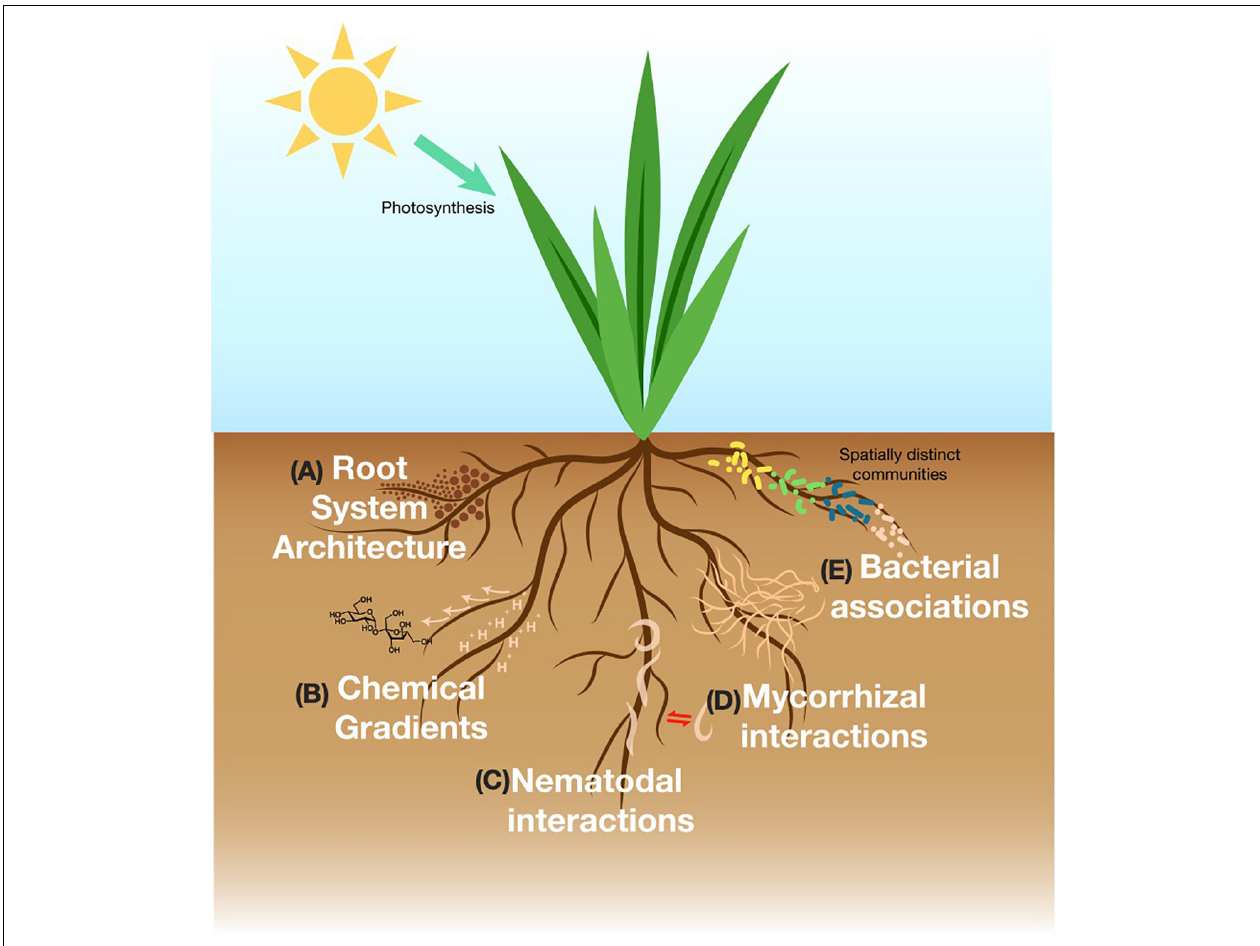
FIGURE 1 | Representative figure of major rhizosphere processes in the soil discussed in this review. (A) Root system architecture is concerned with structural features of the root and responds to with environmental stimuli. (B) The rhizosphere produces photosynthetically fixed carbon that exudes into the soil and influences soil physicochemical gradients. (C) Free-living or parasitic nematodes interact with the rhizosphere via signaling interactions. (D) Mycorrhizal fungi create intimate relationships with the roots and engage in nutrient exchange. (E) Bacterial composition is distinct upon different parts, age, type of the